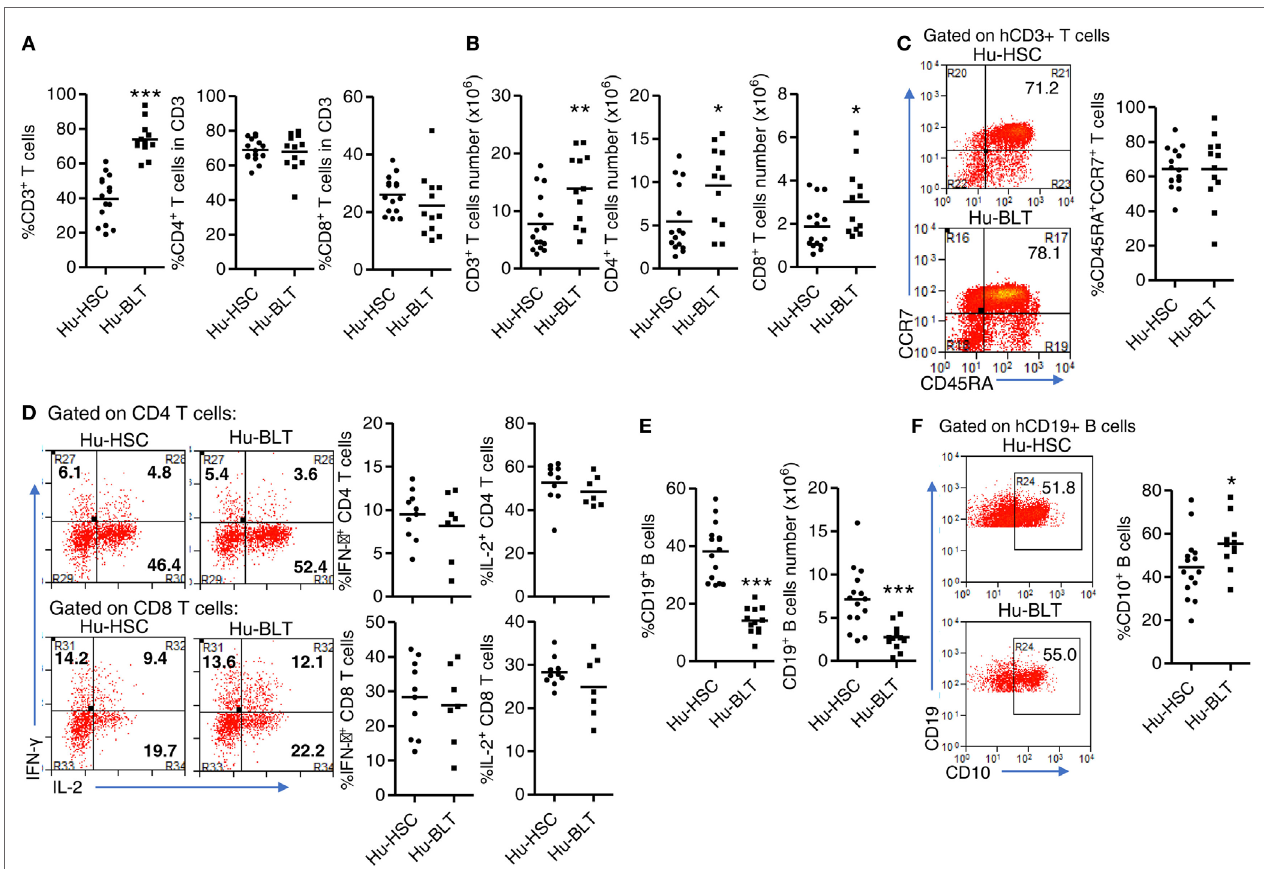
FigUre 3 | Phenotype and function of human T and B cells from NRG-hu HSC and NRG-hu Thy/HSC mice. NRG-hu HSC and NRG-hu Thy/HSC mice were terminated at 20 weeks after reconstitution. (a,B) Summarized data show percentage (a) and number (B) of total human T cells, CD4 T and CD8 T cells in spleen of NRG-hu HSC and NRG-hu Thy/HSC mice. (c) Representative dot plots and summarized data show the expression of CD45RA and CCR7 on CD3 T cells from the spleen of NRG-hu HSC and NRG-hu Thy/HSC mice detected by flow cytometry. Shown (a–c) are data from n = 15 (NRG-hu HSC) and n = 12 (NRG-hu Thy/ HSC) hu-mice per group reconstituted with HSCs/thymus from same donor. (D) Splenocytes were stimulated ex vivo with PMA/ionomycin for 4 h followed by intracellular cytokine staining. Representative dot plots and summarized data show percentages of IFN- γ and IL-2 producing CD4 and CD8 T cells. Shown are data from n = 10 (NRG-hu HSC) and n = 7 (NRG-hu Thy/HSC) hu-mice per group. (e) Summarized data showed percentage and number of total human B cells in spleen of NRG-hu HSC and NRG-hu Thy/HSC mice. (F) Representative dot plots and summarized data show expression of CD10 on B cells from the spleen of NRG-hu HSC and NRG-hu Thy/HSC mice. Shown (e,F) are data from n = 15 (NRG-hu HSC) and n = 12 (NRG-hu Thy/HSC) hu-mice per group reconstituted with HSCs ± thymus from the same donor. Each dot represents one individual mouse; bars indicate mean (* P < 0.05, ** P < 0.01, and *** P < 0.001, by unpaired, two-tailed Student’s t